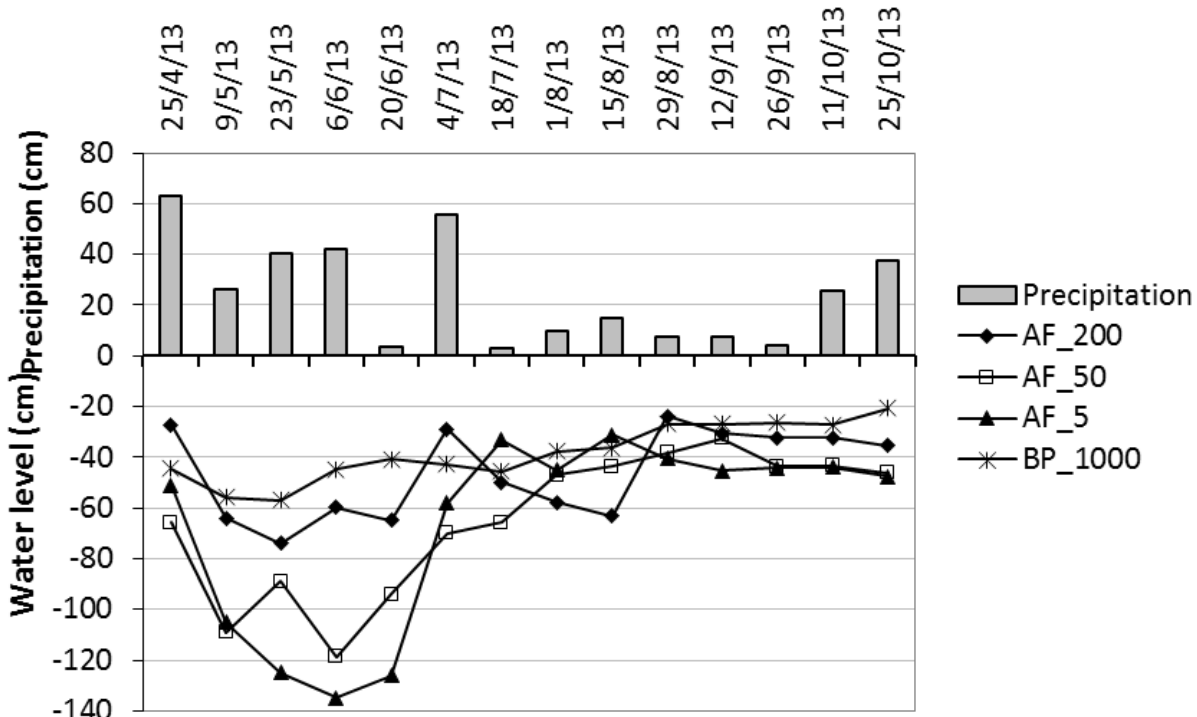
Figure 4. Tumbang Nusa, Central Kalimantan: rainfall and water table levels in the four demonstration plots (three plots with jelutung agroforest (AF) and one on burnt peatland). The numbers in the legend indicate the distance (m) of the plot from the ditch. Data were collected at intervals of approximately two weeks from April to October